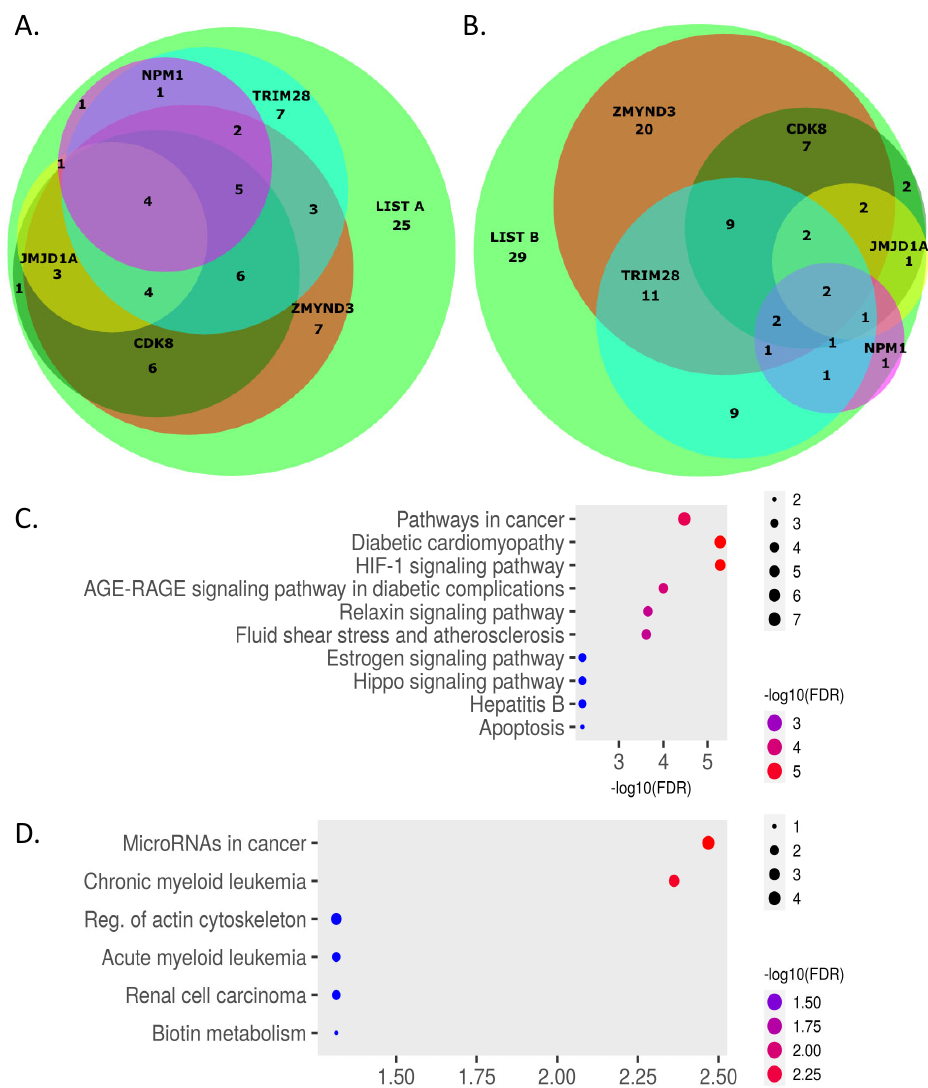
Figure 3. ( A,B ): Venn diagrams depicting the overlap between List A ( A ) or List B ( B ) genes and the five co ‐ activator ‐ dependent gene sets as indicated. ( C,D ) Dot plots of KEGG pathway analysis of List A ( C ) or List B ( D ) genes that do not overlap with any coregulator ‐ dependent gene sets. There is high degree of overlap between List A and co ‐ activator ‐ dependent genes, with the majority of the List A genes (58/83, 70%) also found in at least one of the co ‐ activator ‐ dependent gene sets and more than half of List A genes (42/83, 51%) being com ‐ mon with two or more of the co ‐ activator ‐ dependent genes (Figure 3A and Table S1G). Although only four genes of List A (namely ANGPTL4 , BHLHE40 , BNIP3L and SLC2A1 ) are co ‐ dependent on all five co ‐ activators, it is very likely that these five factors comprise the core of a HIF ‐ 1 ‐ dependent transcriptional activator complex involved in the regulation of many HIF ‐ 1 direct gene targets. KEGG pathway analysis of the List A genes not found in any of the co ‐ activator gene sets (25/83, 30%), shows, in addition to hypoxic or cancer signaling, their involvement in other, apparently unrelated, pathways (Figure 3C), indi ‐ cating limited expression that may explain their non ‐ detection in the co ‐ activator tran ‐ scriptomic analyses.